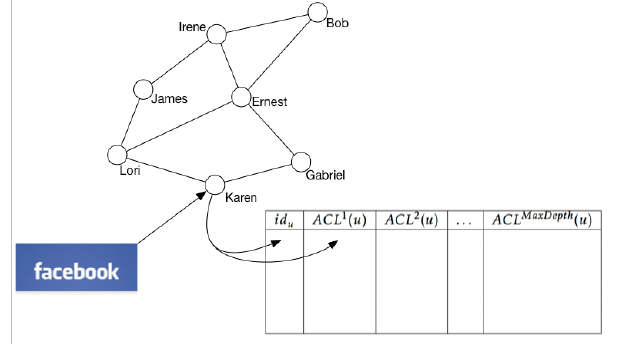
Figure 2. Example of the propagation procedure - phase 1